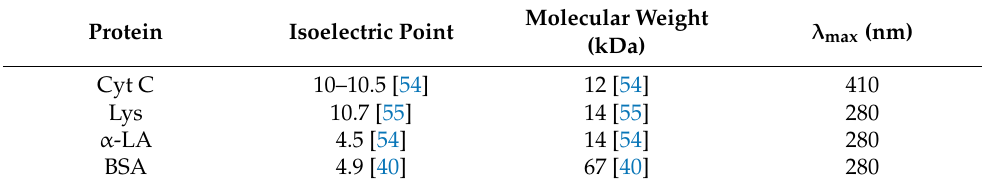
Table 1. Characteristics and properties of tested